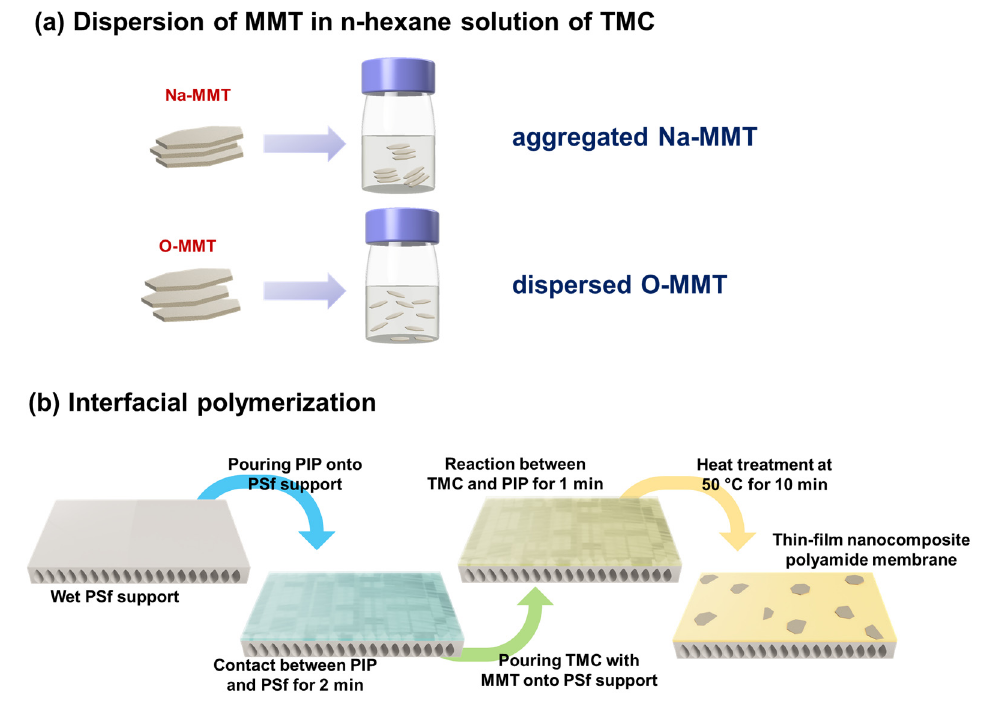
Figure 1. Schematic diagram of membrane preparation.